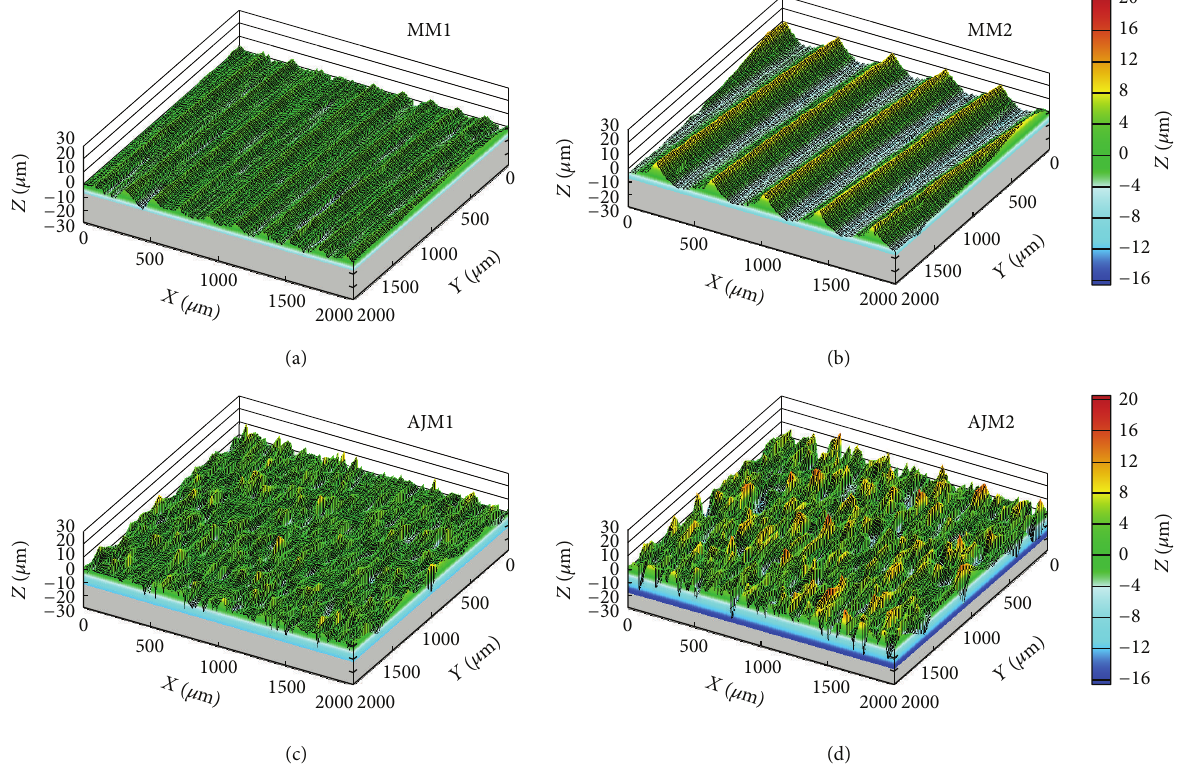
Figure 4: 3D profiles of surface morphology of test